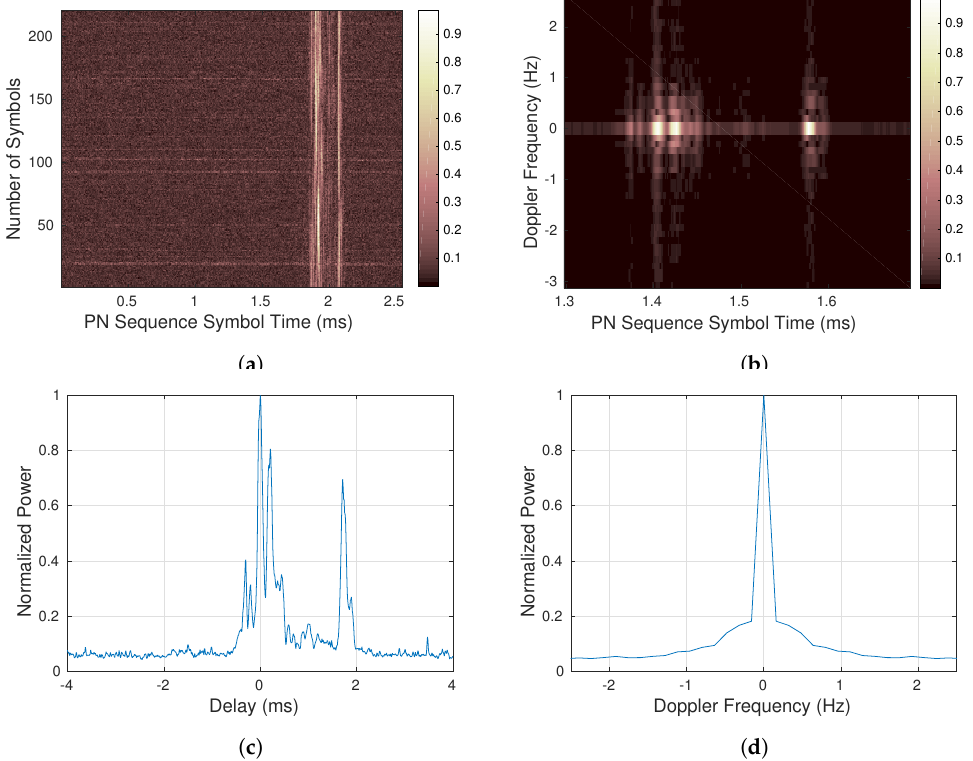
Figure 12. Wideband channel response for February 1st 2014 at 07 UTC with 13 MHz of carrier frequency: ( a ) normalized channel response h [ n , τ ] , ( b ) normalized scattering function R s [ τ , v ] , ( c ) multipath power profile (in ms), ( d ) Doppler power profile (in